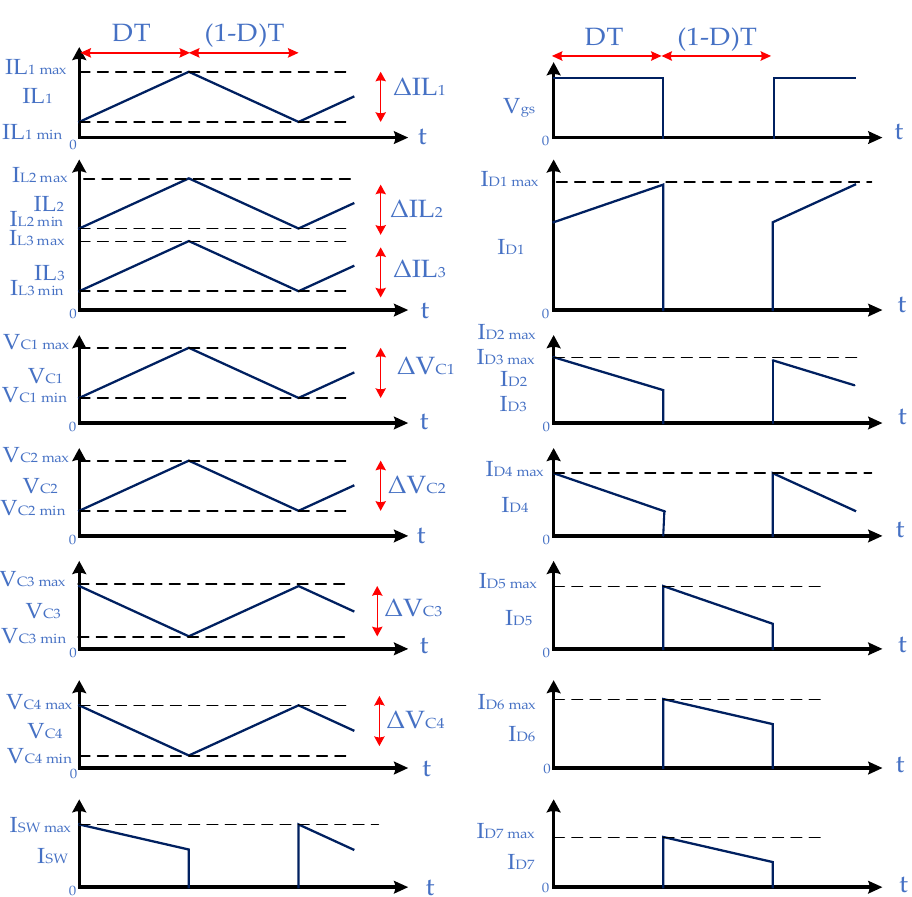
Figure 6. Steady-state waveform of the proposed HVGSU converter. 3.1. Operation of Proposed HVGSU Converter Con fi guration (Mode 1: SW Turn On)